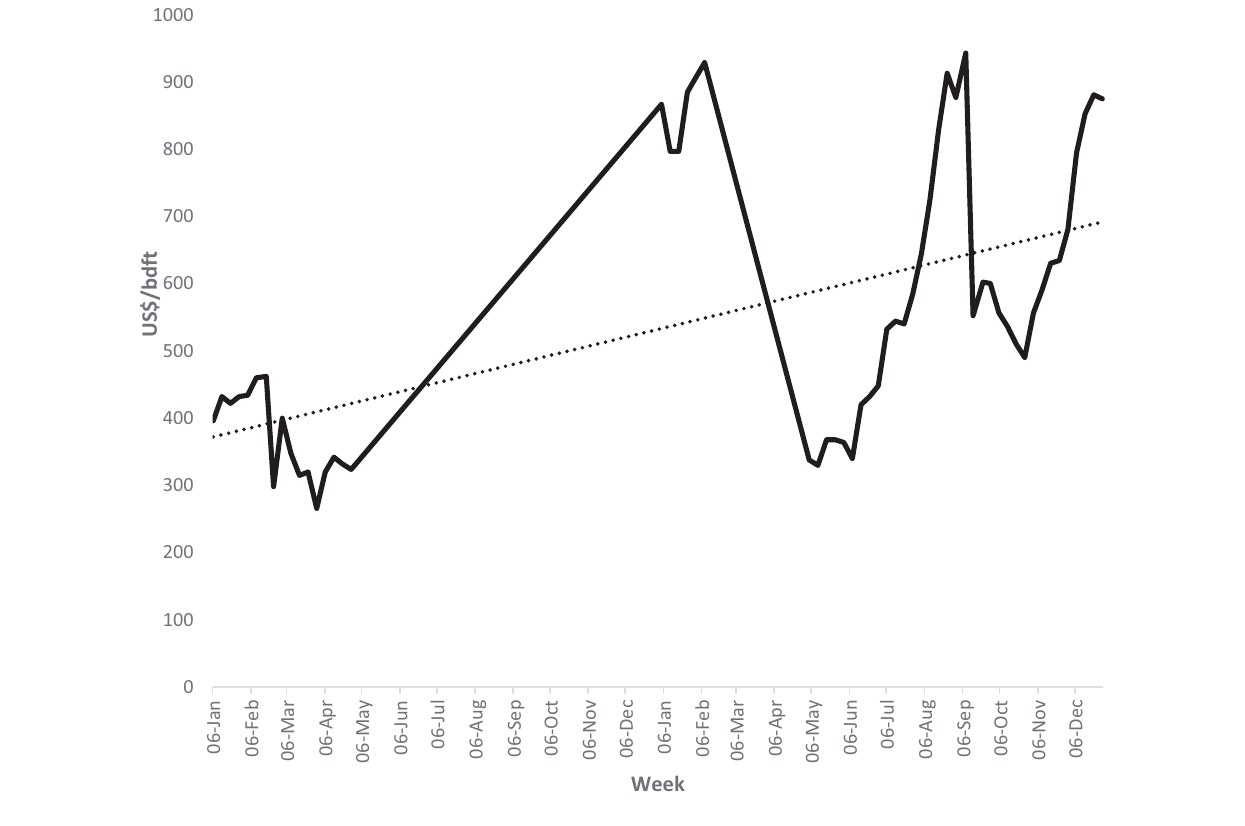
Frontiers in Forests and Global Change |